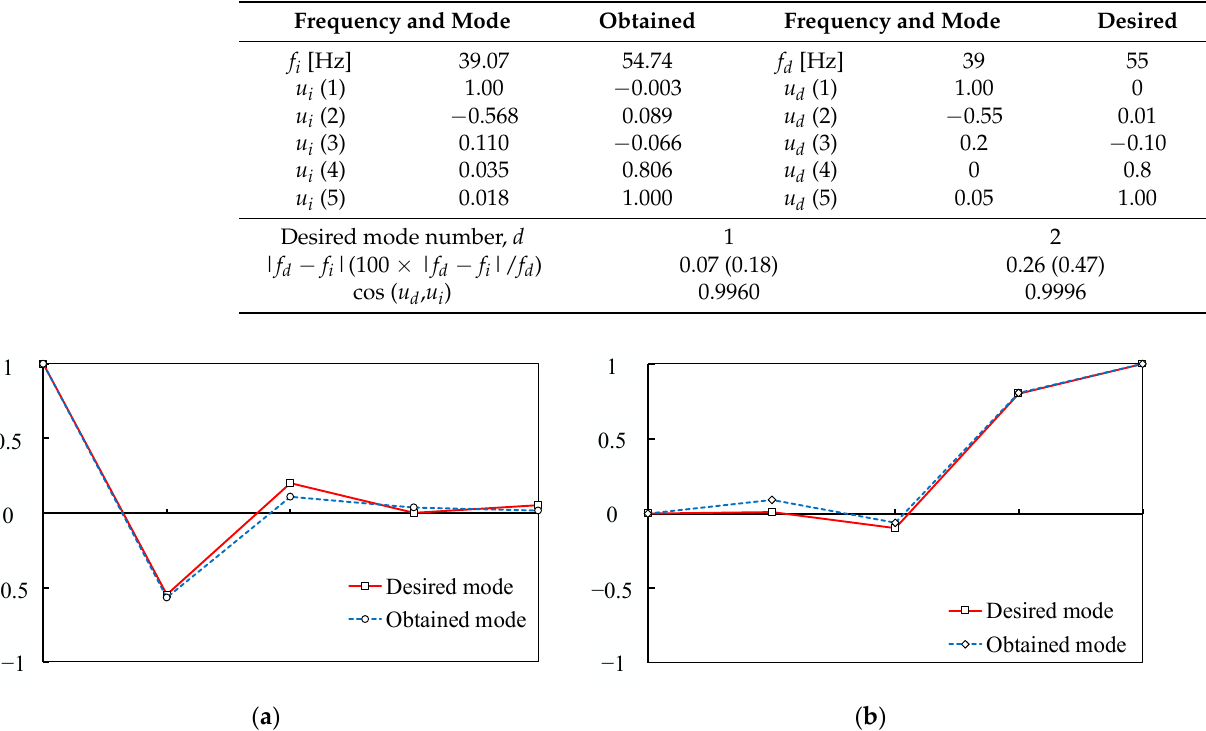
Figure 29. Comparison of desired and attained modes: ( a ) 39 Hz; ( b ) 55 Hz. Compared with the addition of masses or supporting stiffness, the simultaneous addition of masses and stiffness clearly demonstrated better performances in both mode shapes and frequencies assignment. We believe that this was because the number of modifying quantities was increased from five (five added masses or five added stiffness) to ten (five added masses and five added stiffness).